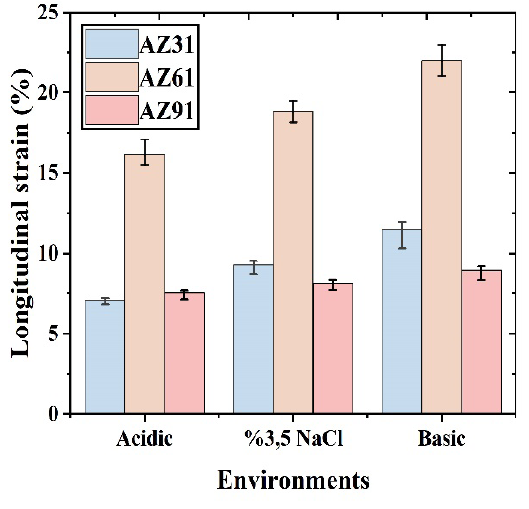
Figure 5: Elongation (%) of AZ31, AZ61 and AZ91 Mg alloys in different